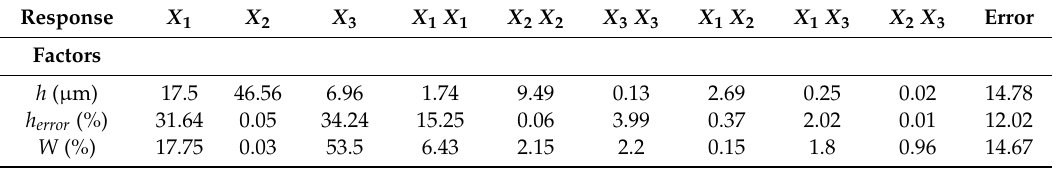
Table 2. Contribution of significant main factors (in %), their interactions and quadratic e ff ects of factors from the model for each of the responses, with X 1 = Fluence, X 2 = Pulse overlap and X 3 = Hatch Distance.